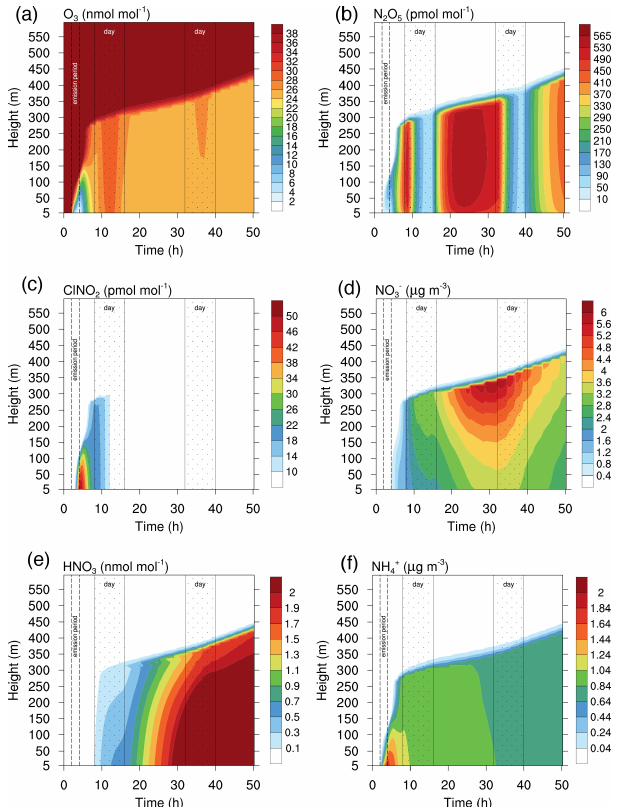
Figure 4. Contour plots of important gas-phase species. Modeled NO − and NH + are total aerosol mass density (sum of all aerosol 3 4 particle sizes). Daytime regions are indicated by the dotted region and the emission period is indicated by the dashed